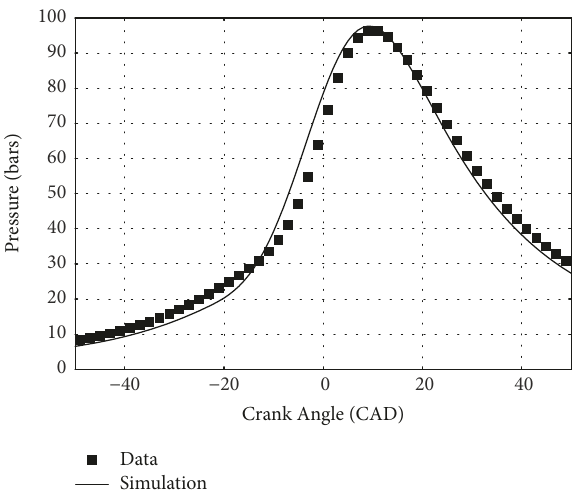
Figure 1: Temporal cylinder pressure (simulation and experimental data).